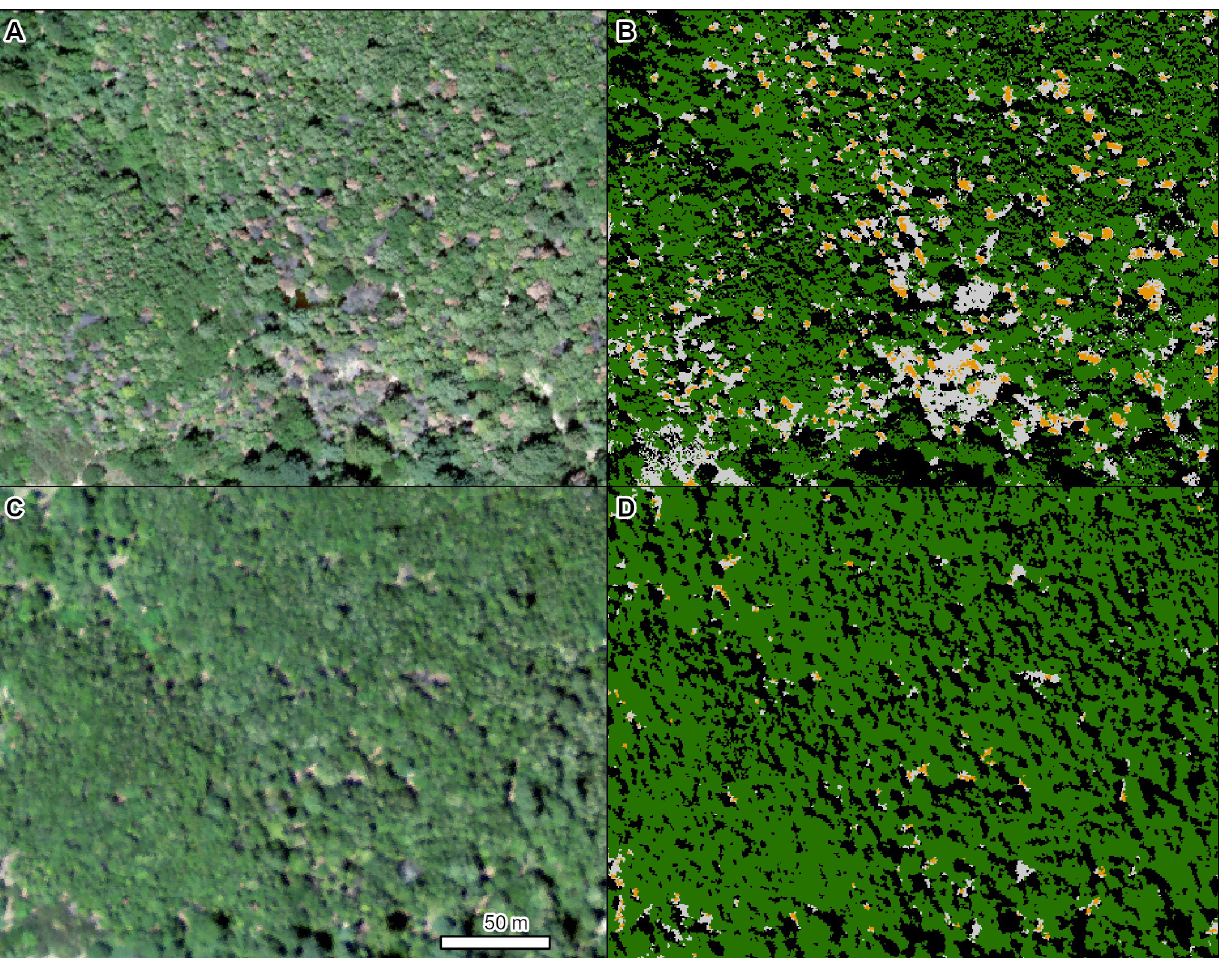
Fig 5. Mortality of tanoak ( Notholithocarpus densiflorus ) caused by sudden oak death ( Phytophthora ramorum ). Left panels are NAIP imagery from 2018 (A) and 2012 (C). Right panels (B, D) are the corresponding TCH model results from each year (orange = red crowns, light gray = gray crowns, dark green = green crowns, black = shadowed crowns). Location: Northern California. Insect and Disease Survey database DAMAGE_AREA_ID: {015c6d5a- ee89-4f6c-a3ea-7799b6401bfc}. NAIP imagery (public domain) provided by USDA-FSA-APFO.